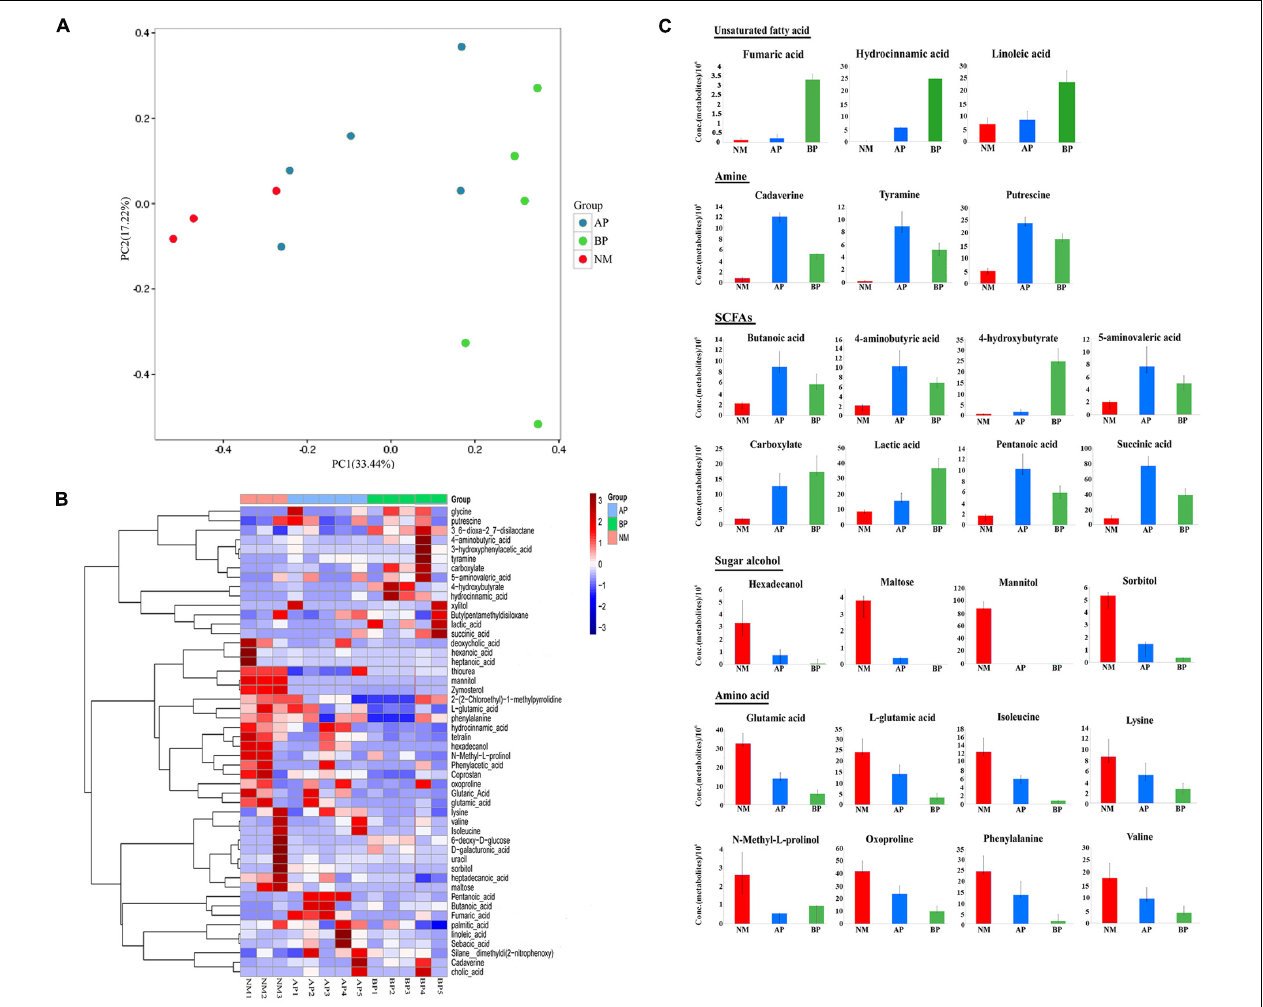
FIGURE 2 | Characteristics of metabolites from fecal samples of cirrhotic patients compared with the normal. (A) Principle component analysis (PCA). The analysis was based on unweighted UniFrac distance matrix of all metabolites concentrations from fecal samples of the cirrhotic patients (AP and BP) and the normal. (B) Color-coded heat map displaying the cirrhosis related relative fecal metabolites amounts compared to the normal. Hierarchical clustering of the metabolic profiling data at NM (red bars), AP (blue bars), BP (green bars). The color scale represents the scaled abundance of each metabolite, denoted as Z -score, with red and blue indicated increased and decreased concentrations, respectively. (C) Cirrhosis related common sets of metabolic perturbations. Fecal samples of the subjects were taken for metabolic profiling. The values displayed are the average concentrations of each metabolite. Columns are colored according to the groups: red: NM; blue: AP; green: BP. Data are shown as mean values ± SD for each